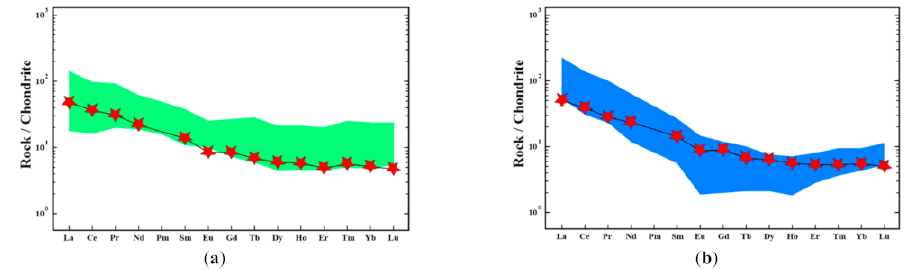
Figure 10. Comparison of the studied black sands (whole rock) REE pattern with the REE whole rock pattern from ( a ) Fanos (green area) and ( b ) Monopigado granitic rocks (blue area). Data from [10,11]. Symbol (red star) as in Figure 5.